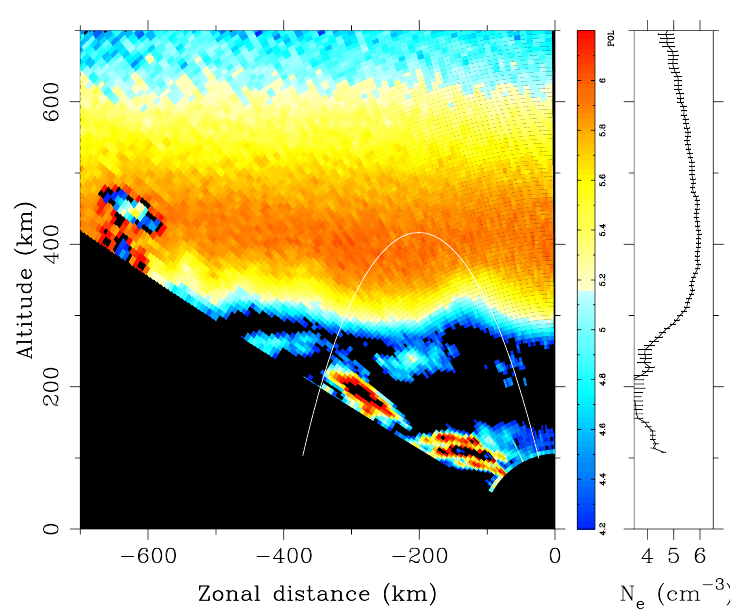
Fig. 5. Altair radar perpendicular scan for 7 August 2004, 08:58 UT. The white arc represents the location of the instrument payload, mapped along geomagnetic field lines to the plane perpendicular to B scanned by the radar. Echoes between 150–200km apparent altitude are due to tropospheric